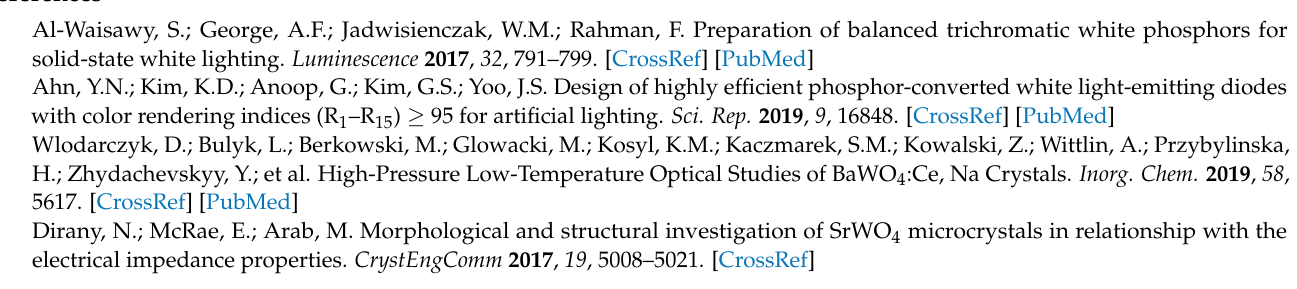
Figure 9. Images of flexible composite under daylight and UV